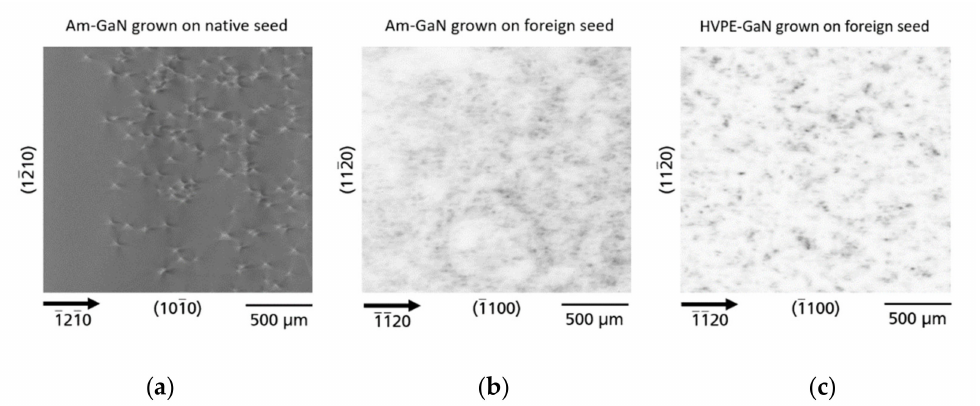
Figure A2. Topograph of an ammonothermally grown substrate (wafer thickness 450 µ m) with native seed (sample C of this study) ( a ) and, in comparison, a topograph of an ammonothermally grown GaN substrate (wafer thickness 300 µ m) with a foreign seed history ( b ), as well as a topograph of an HVPE-GaN (wafer thickness 460 µ m) also grown by means of a foreign seed ( c ). All topographs were measured with symmetrical equivalent type 1120 reflections and identical integration times. The Borrmann effect for the Am-GaN sample with a native seed is clearly recognizable by the strong intensity and contrasts of a few TDs are visible. On the contrary, for the other two substrates the intensity of the topographs is only weak. This means that the Borrmann effect is hardly present in these samples due to the high defect